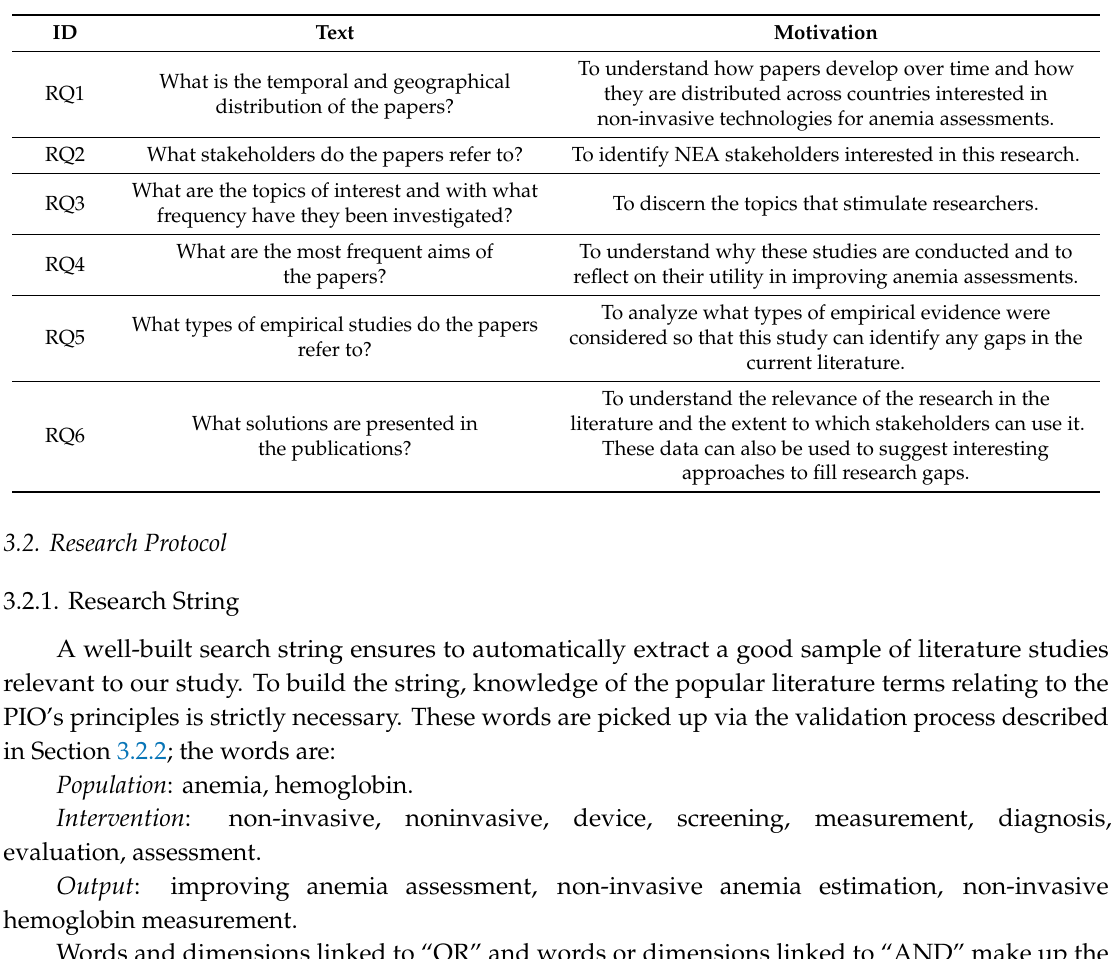
Table 1. Research